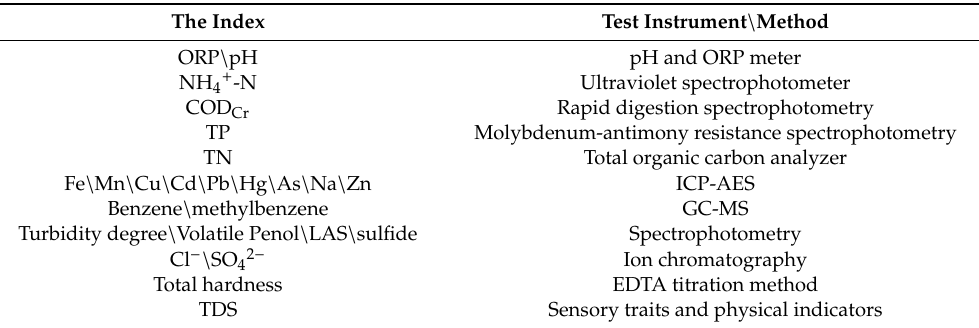
Figure 5. Water collection points in the landfill. Table 2. Water quality testing